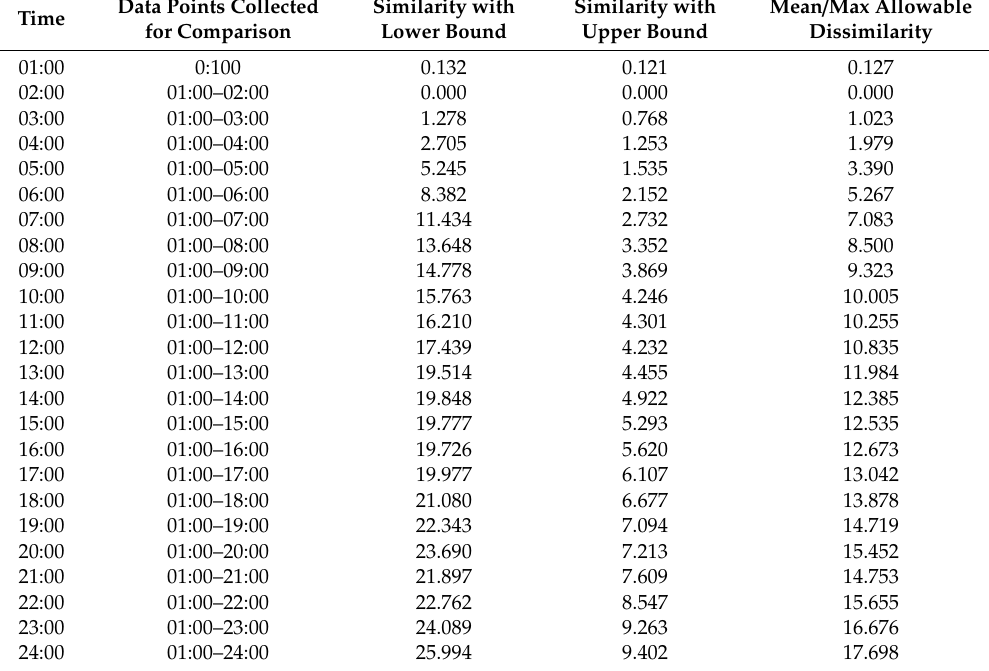
Figure 9. Flowchart of algorithm. Table 1. Similarity for weekday median series against upper and lower bound